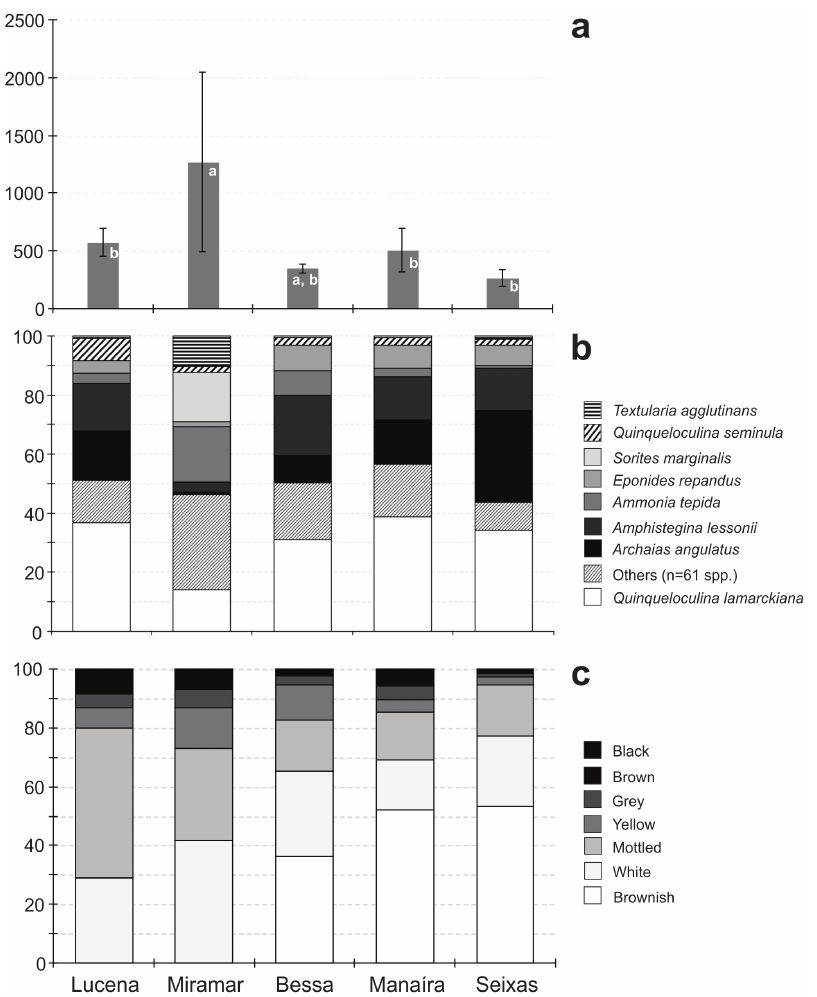
Figure 4. Mean density (a; ind./cm 3 ), relative abundance of dominant species (b; %) and colors (c; %) of dead foraminiferans from João Pessoa metropolitan area. Error bars in a represent the standard deviation and the lowercase letters indicate the result of the Tukey’s posterior test; beaches sharing at least one letter do not differ (p>0.05) from each